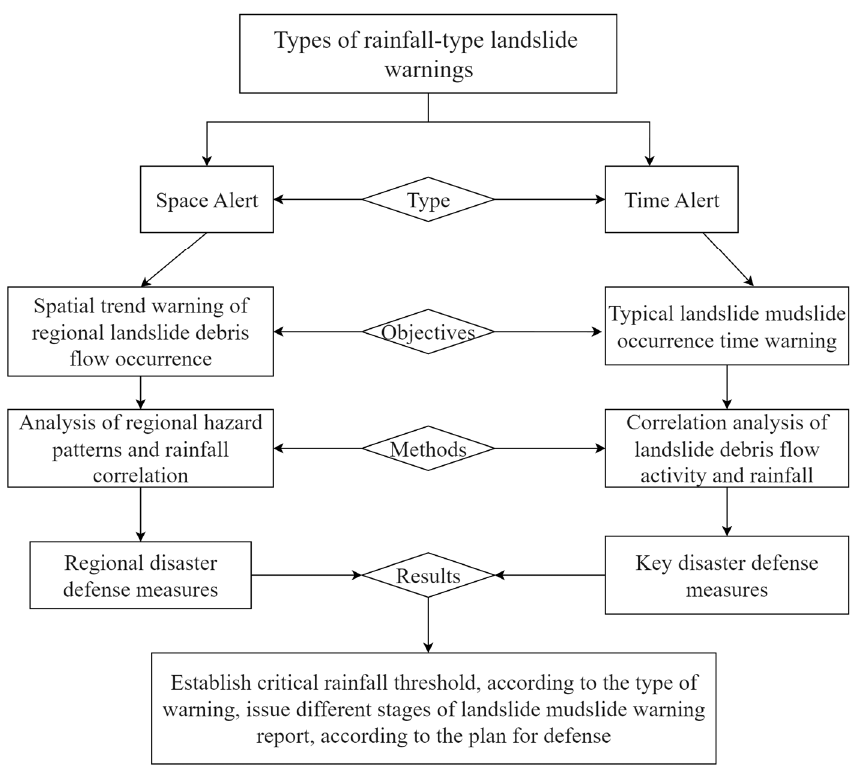
Figure 9. Flow chart of landslide debris flow warning.